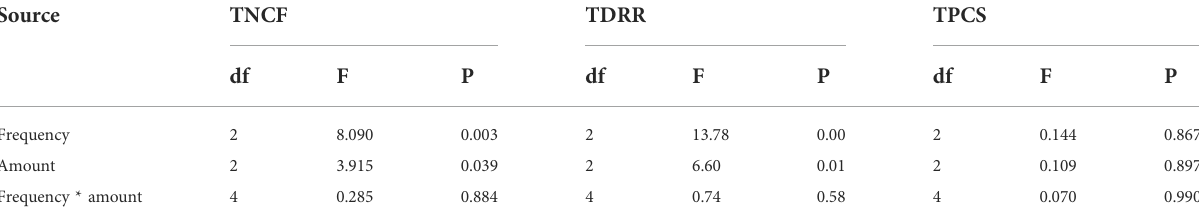
TABLE 2 Variance analysis of effects of precipitation amount and frequency on TNCF, TDRR, and TPCS.